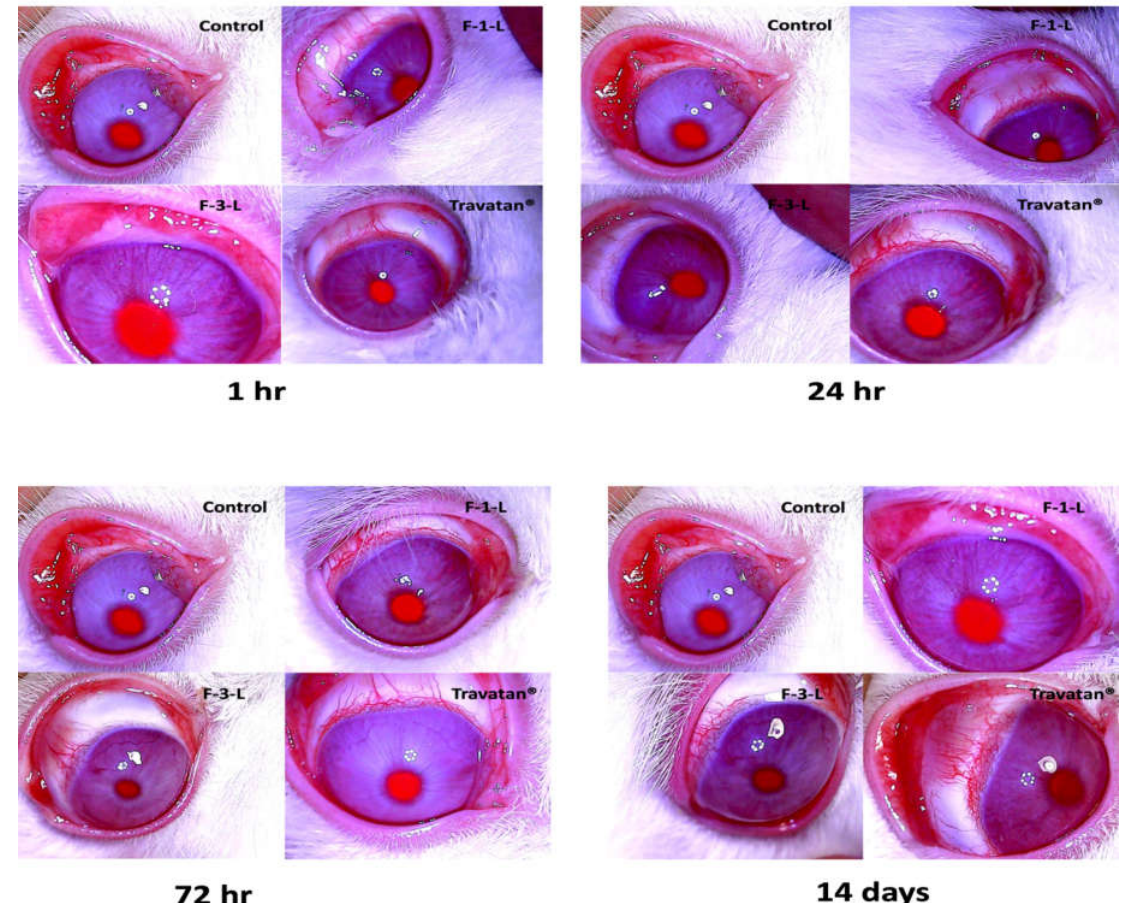
Figure 8. Images of rabbits’ eyes post-application of the tested samples. No physiological difference is observed between the eyes treated with the optimized LCNs (F-1-L) and (F-3-L) and the marketed product (Travatan ® ) compared to the control eye.